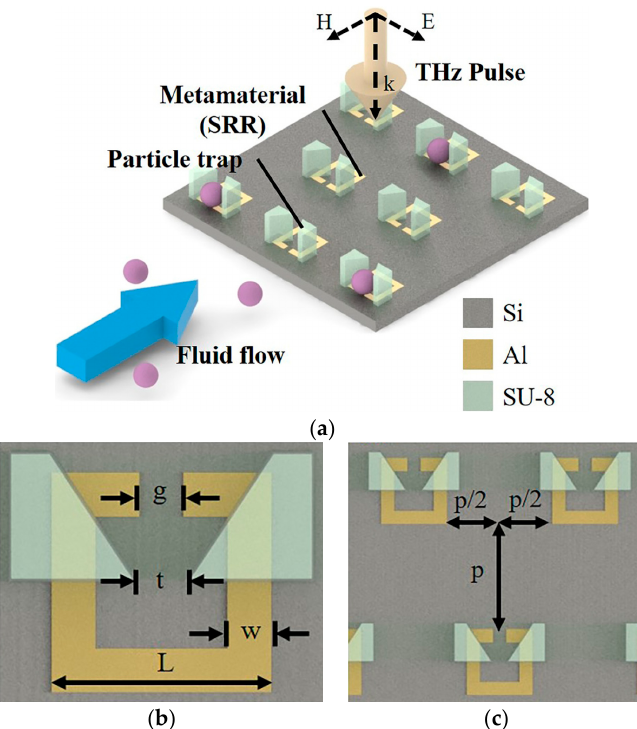
Figure 8. ( a ) SRR based sensor array (operating at THz frequency) integrated with a microfluidic system consisting of trapezoidal shaped structure to entrap the liquid particles of analyte. ( b ) Geometrical parameters of a unit cell (a SRR), and aligned-position of corresponding trapping structure, g = t = w = 5 µm, L = 30 µm; and ( c ) array design by integrating several unit cells from ( b ) with p = 50 µm (redrawn from [42]).